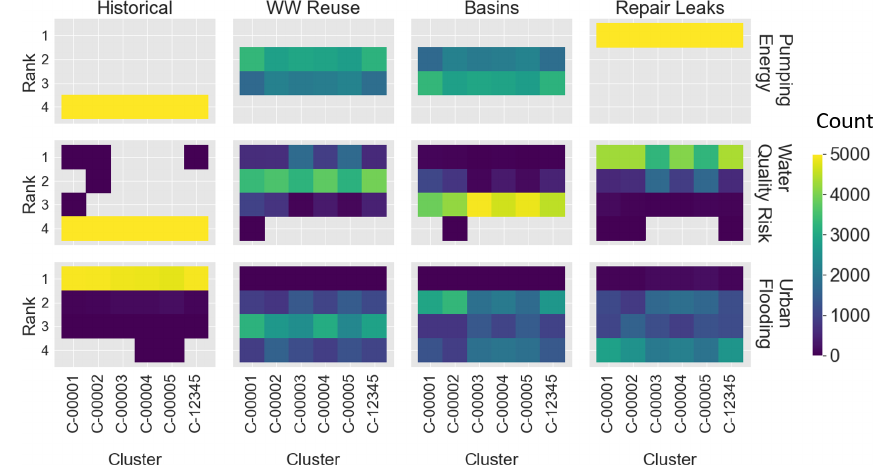
Figure 7. Alternative performance across the observation cluster parameter sets shown as heat maps of the count of sets where the alternative performance was ranked from (1) best to (4) worst. Within each heat map, the rows are the rank, and the columns are the cluster behavioral parameter sets. The subplots are organized by the three management objectives (rows) and the aquifer management alternatives (columns).